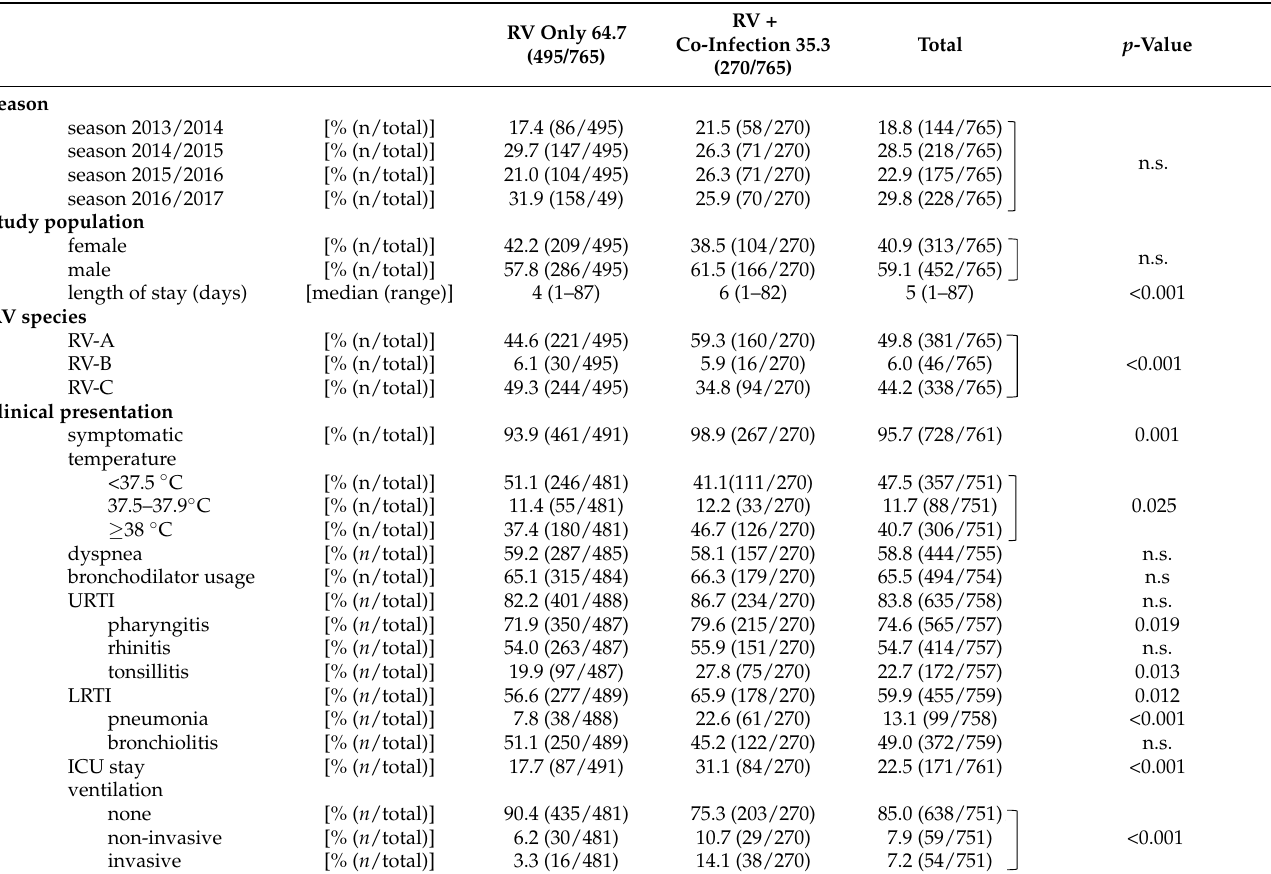
Table 4. Comparison of samples with and without co-infections.